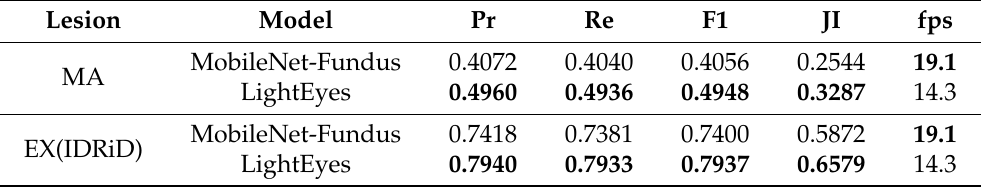
Table 10. Comparison with MobileNet on lesion segmentation (Best results are